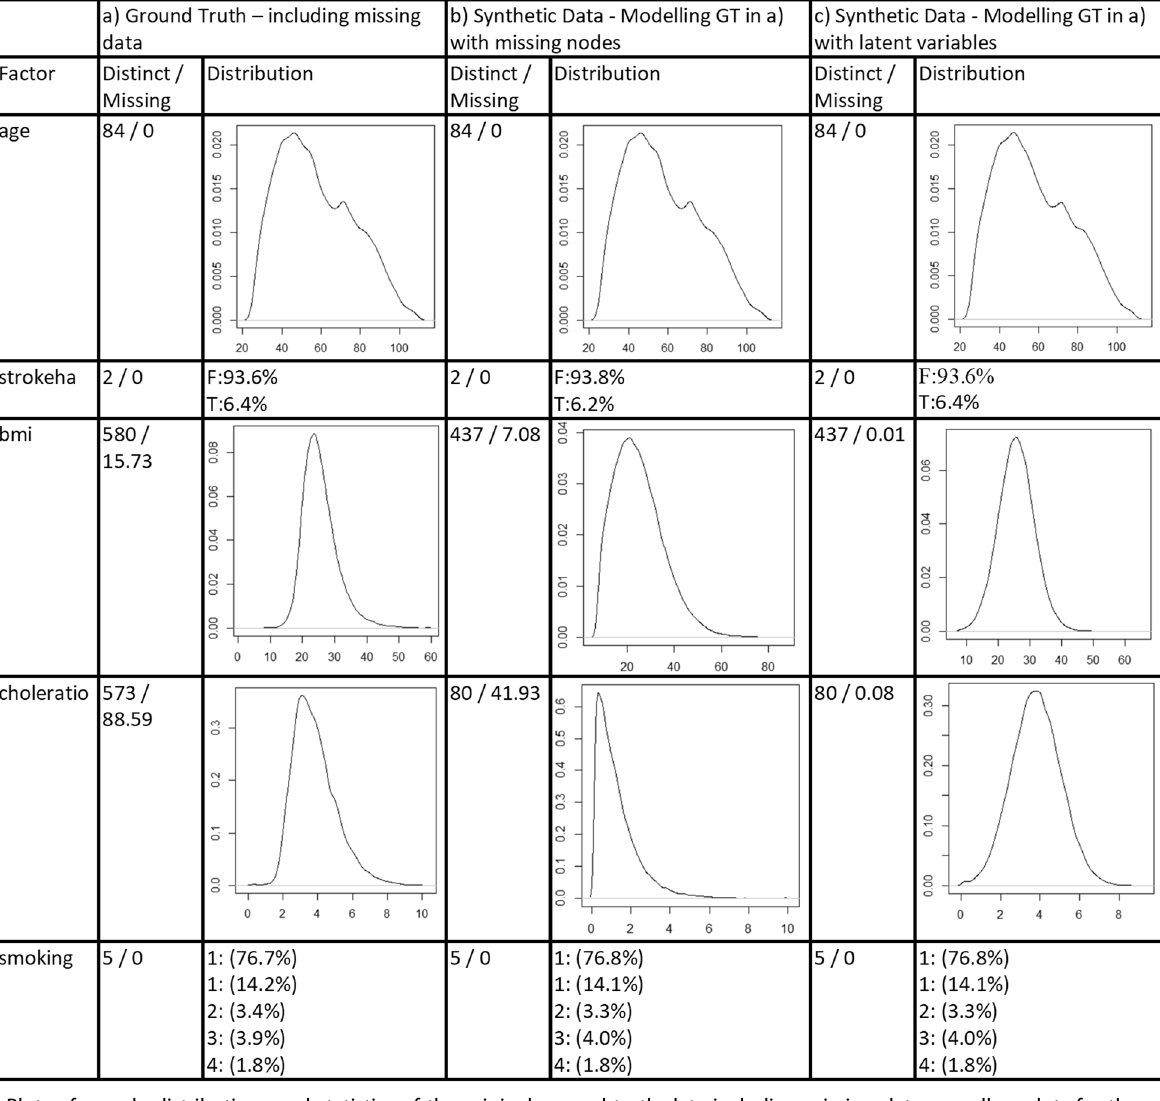
Fig. 3 Plots of sample distributions and statistics of the original ground truth data including missing data as well as plots for the synthetic data that models missing data with “ Miss Nodes/States ” and with latent